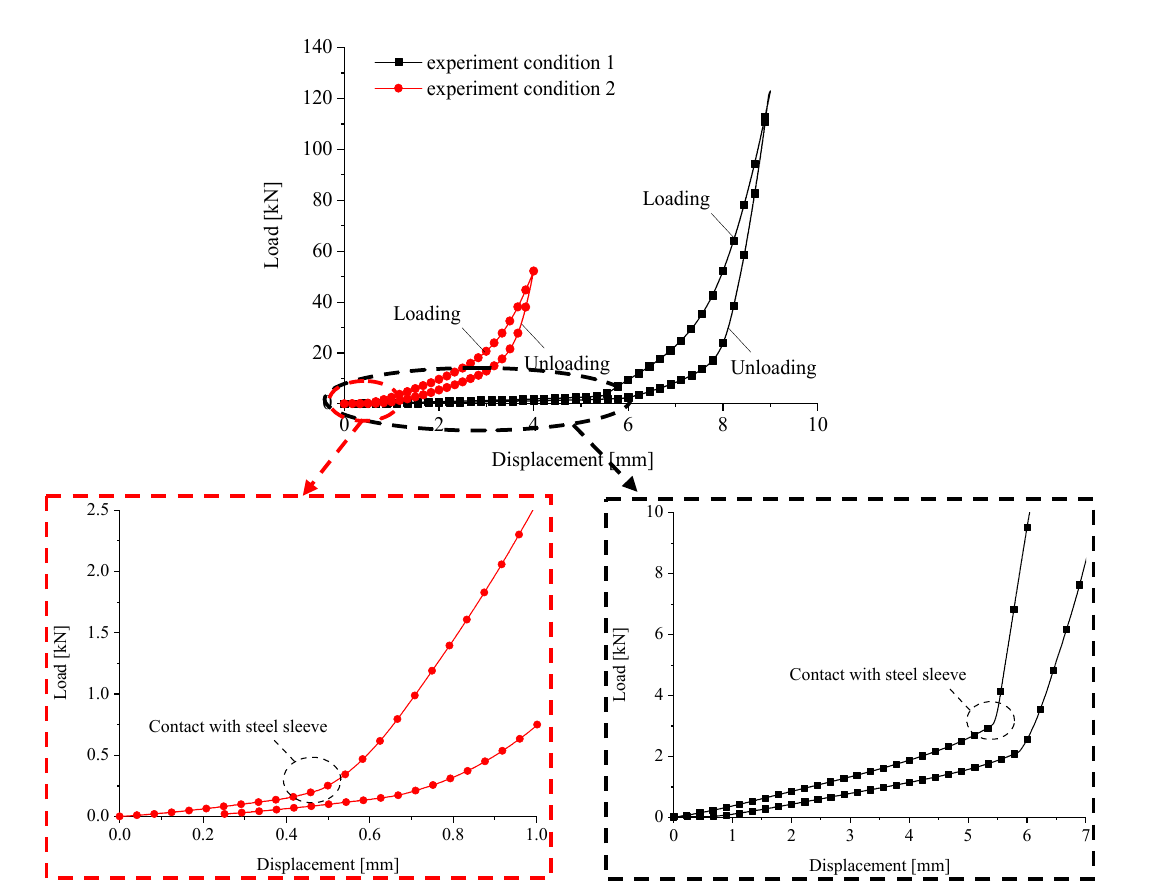
Figure 8. Load–displacement curve.